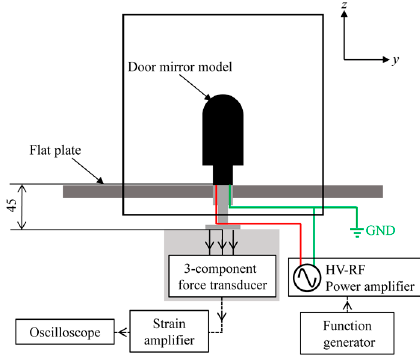
Figure 6. Experimental setup for force measurement.